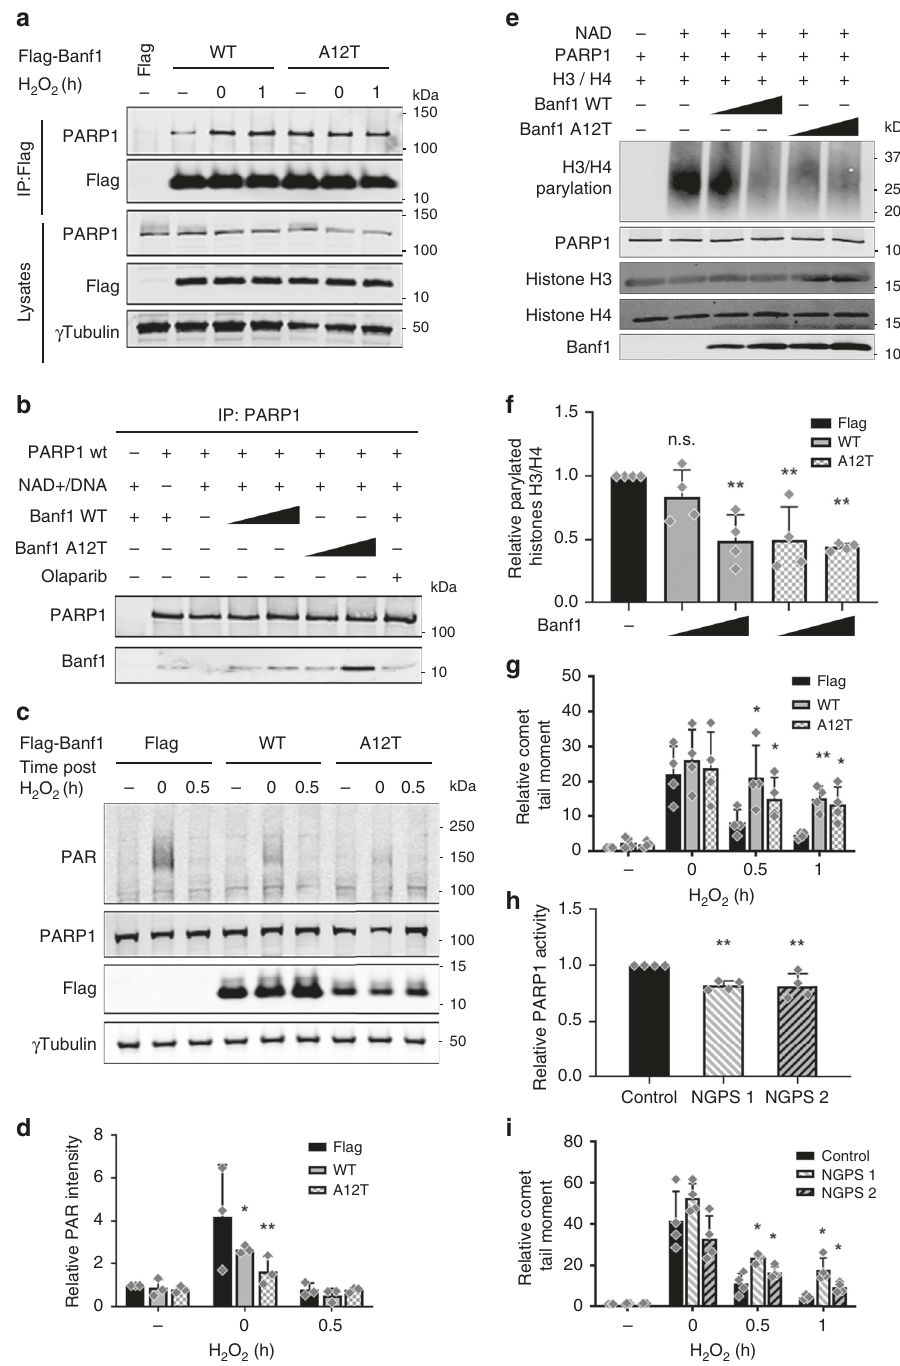
Fig. 5 Banf1 A12T inhibits repair of oxidative lesions in NGPS patient cells. a Interactions of PARP1 with Flag-Banf1 mutants. Flag immunoprecipitations from HEK293T cells ectopically expressing the Flag-Banf1 WT or A12T proteins following H 2 O 2 . b Puri fi ed Banf1 WT or A12T proteins were incubated with PARP1, immunopreciptated with PARP1 antibodies and immunoblotted with the indicated antibodies. c Inhibition of auto-poly-ADP-ribose activity of PARP1 in U2OS expressing ectopic Flag-Banf1 WT or A12T following H 2 O 2 . d The PAR bands in ( c ), were analysed via densitometry and normalised to γ -Tubulin. Histogram data shown in ( d ), represent the mean and S.D. of three independent experiments. e In vitro inhibition of PARP1 poly-ADP-ribose activity on histones by puri fi ed Banf1 WT or A12T. f The PAR bands on ( e ), were analysed via densitometry. g Banf1 inhibits repair of oxidative DNA damage. Alkaline comet assay showing the relative olive tail moment in control cells and cells ectopically expressing Flag-Banf1 WT or A12T following H 2 O 2 treatment and recovery. Paired t test was used for statistical analysis. h Inhibition of Poly-ADP-ribose activity of PARP1 puri fi ed from NGPS patient cells on an immobilised histone substrate HEK293T following H 2 O 2 . i NGPS patient cells exhibit defective repair of oxidative DNA damage. Alkaline comet assay showing the relative olive tail moment in control cells and NGPS cells after H 2 O 2 treatment and recovery. Paired t test was used for statistical analysis. Immunoblots are representative of n = 3 independent experiments. Unless otherwise stated, histogram data shown represent the mean and S.D. of n = 4 independent experiments and statistical signi fi cance was de fi ned via ANOVA. * P < 0.05, ** P < 0.01. Source data are provided as a Source Data fi